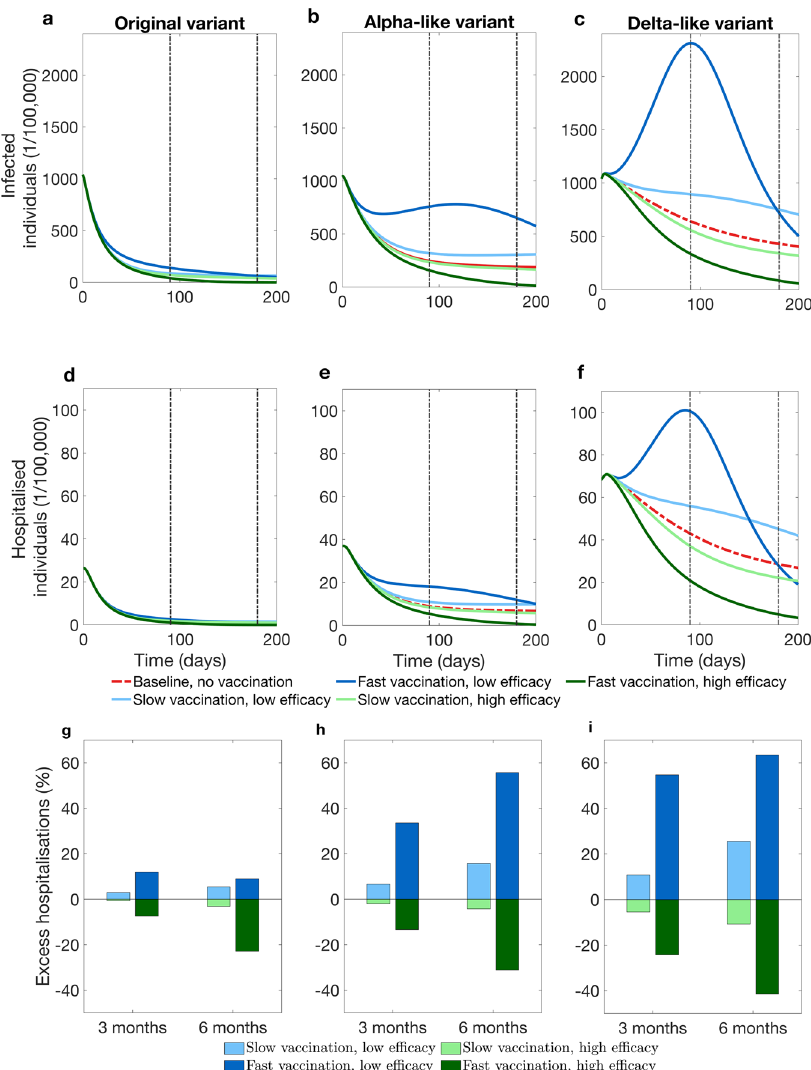
Fig. 3 Epidemic dynamics with and without vaccination. a Prevalence of infected individuals versus time when the original variant circulates. b The same output when an Alpha-like variant circulates. c The same output when a Delta-like variant circulates. d Prevalence of hospitalised individuals versus time when the original variant circulates. e The same output when an Alpha-like variant circulates. f The same output when a Delta-like variant circulates. g Difference in the cumulative number of new hospitalisations relative to the no-vaccination scenario level for the original variant. h The same output when an Alpha-like variant circulates. i The same output when a Delta-like variant circulates. g – i show the difference in the cumulative number of new hospitalisations relative to the no-vaccination levels when respective variants circulate. Red curves on a – c correspond to no-vaccination scenario. Blue curves correspond to a vaccine with 60% ef fi cacy in conferring protection against infection (low ef fi cacy), green curves correspond to vaccine with 91% ef fi cacy (high ef fi cacy). In a – f , vertical brown lines mark three and 6 months since the start of Fig. 3 for vaccine with low ef fi cacy. Re-call that the primary goal of COVID-19 vaccine was to reduce the probability of developing a severe disease as a result of becoming infected. Therefore, if a large proportion of infected population has been vaccinated, the temporary rise in prevalence may not necessary translate to a large increase in hospitalisation numbers. To identify conditions when this happens, we considered the proportion of infections occurring in the vaccinated population over time (Fig. 4) given low ef fi cacy in conferring immunity against infection acquisition (60%). The analyses show that in the case of slow vaccine uptake (Fig. 4a – c) vaccinated individuals comprise a small proportion of the infected population even at the end of the 6 months of the vaccination campaign (Fig. 5a – c). Therefore, the increased pre- valence among non-vaccinated can be attributed to the decrease of their compliance with physical distancing measures.